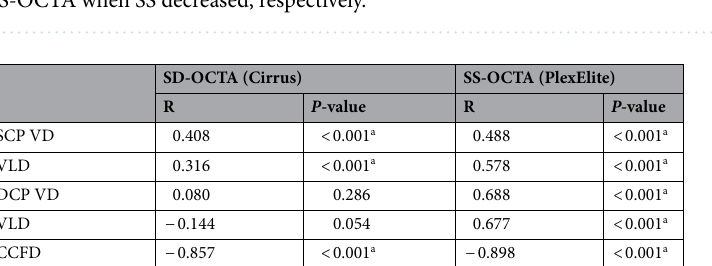
Figure 3. Representative 6 × 6 mm en face choriocapillaris (CC) optical coherence tomography angiography (OCTA) images with application of neutral density filter (NDF) of a 35-year-old healthy male subject. Signal strength (SS) decreased significantly more for spectral domain OCTA (SD-OCTA) than swept-source OCTA (SS-OCTA). The CC images became dark since the areas of black pixels increased when SS decreased. The CC flow deficit (CCFD) increased from 31.4–42.0 to 53.7% for SD-OCTA, and from 22.4–28.3 to 38.7% for SS-OCTA when SS decreased, respectively.